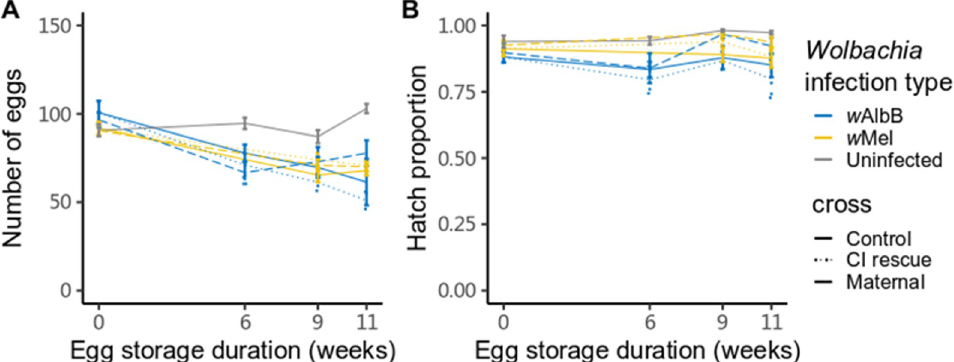
Fig 5. Fecundity and egg hatch of fertile females derived from stored eggs crossed to different male lines. (A) Fecundity and (B) egg hatch proportions of eggs from female mosquitoes that were derived from eggs stored under a cycling temperature of 22–30˚C for 0, 6, 9 or 11 weeks. Females hatched at each time point were crossed to males from the same treatment (Control), crossed to males with the same Wolbachia infection type that stored under 26˚C for less than three weeks (CI rescue) and crossed to uninfected males stored under 26˚C for less than three weeks (Maternal). The data exclude females that did not lay eggs (see Fig 4). Error bars represent means ± standard errors.